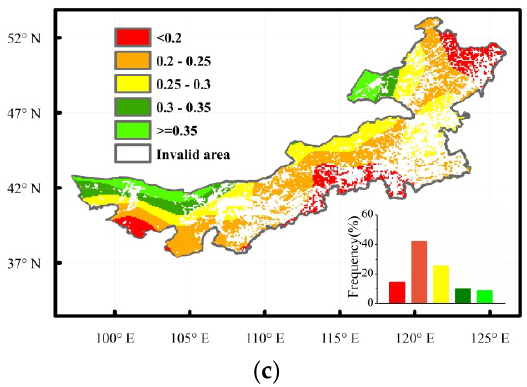
Figure 2. Spatial distributions of the coefficient of variation (CV) of the growing season normalized difference vegetation index (NDVI ) ( a ), temperature ( b ), and precipitation ( c ) in Inner Mongolia during 1982–2015. The insets show the frequency distributions of the corresponding CV values. At the biome scale, the CV values of the growing season NDVI show large variations among the six vegetation types (Figure 3a). The lowest variation occurred in the forest biome (0.037), whereas the average growing season CV value was 0.044 for desert, 0.067 for meadow steppe, 0.095 for typical steppe, 0.096 for desert steppe, and 0.072 for crop. These findings indicate that typical steppe and desert steppe were less stable than the other biomes. Additionally, the temperature showed fluctuation trends nearly opposite to those of the growing season NDVI across all biomes except for desert and crop (Figure 3b). The maximum CV value for the growing season precipitation was 0.28 for desert and the minimum was 0.22 for forest and crop, which were much higher than the corresponding values for NDVI and temperature (Figure 3c).